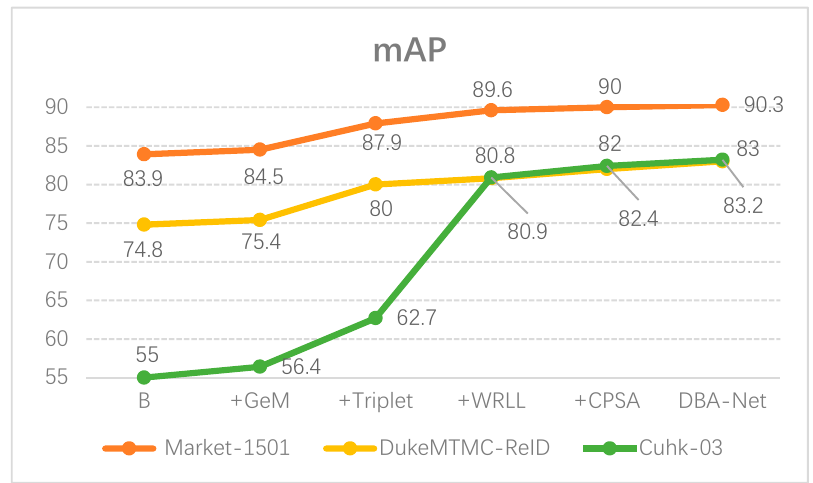
Figure 8. The mAP value of DBA ‐ Net on three datasets.